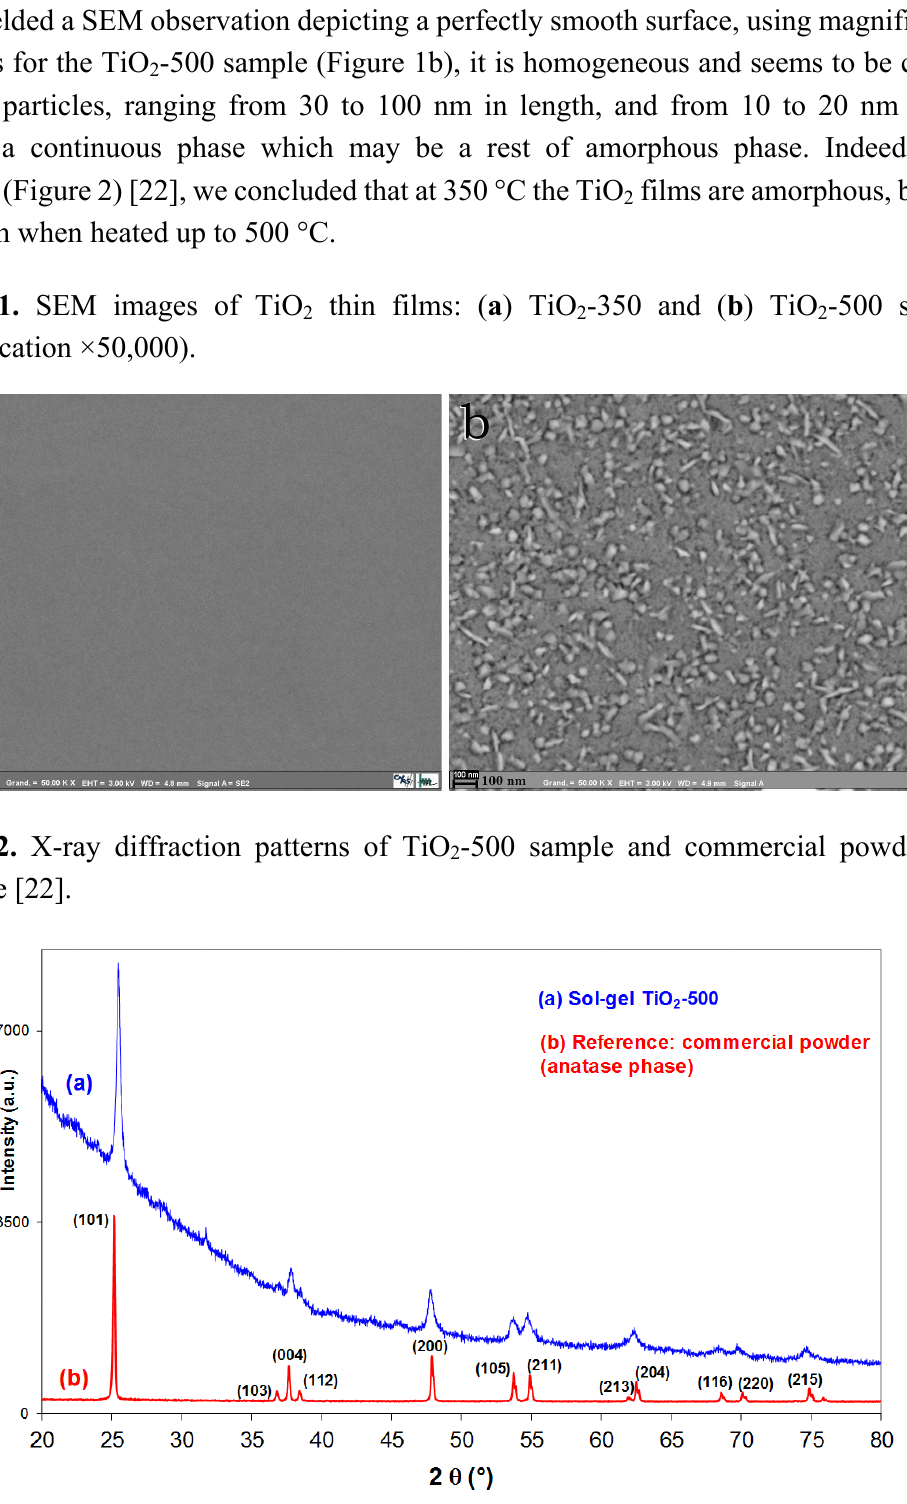
thin films: ( a ) TiO 2